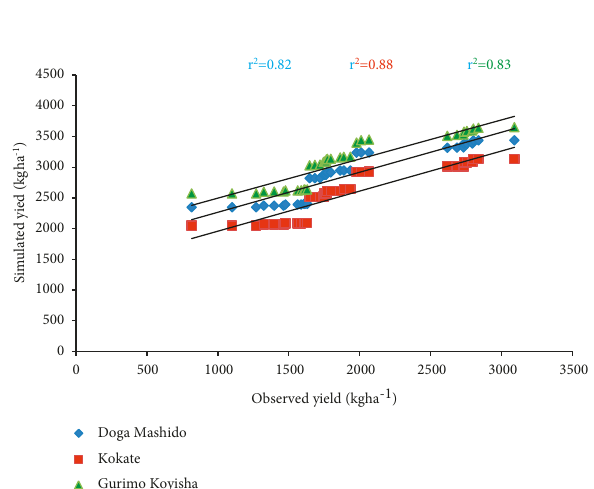
Figure 2: Relationships between the simulated and observed yields in the three